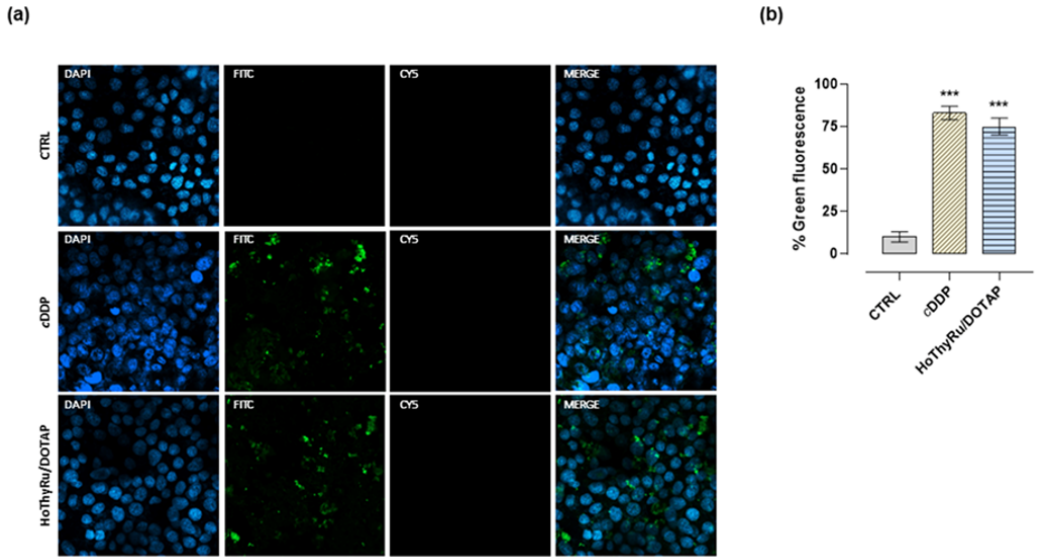
Figure 4. Apoptosis activation in MDA-MB-231 cells by confocal microscopy in response to HoThyRu/DOTAP treatment. ( a ) Apoptotic, necrotic, and healthy cells have been monitored by confocal microscopy after incubation for 48 h with IC 50 concentrations of HoThyRu/DOTAP and cisplatin (cytotoxic positive control). Nuclei emit blue fluorescence (blue nuclear stain, DAPI filter, Ex/Em = 350/470 nm). Apoptotic cells have green fluorescence (FITC filter, Ex/Em = 490/525 nm) upon binding to membrane PS (phosphatidylserine). Necrotic cells are associated with nuclear red fluorescence (Cy5 filter, Ex/Em = 546/647 nm). In merged images (Merge), the fluorescent patterns from cell monolayers are overlapped. Fluorescent microphotographs (40 × oil immersion objective lens) are representative of three independent experiments. ( b ) Percentage of Green Detection Reagent- positive MDA-MB-231 cells following the indicated treatments in vitro with respect to untreated control cells. *** p < 0.001 vs. control